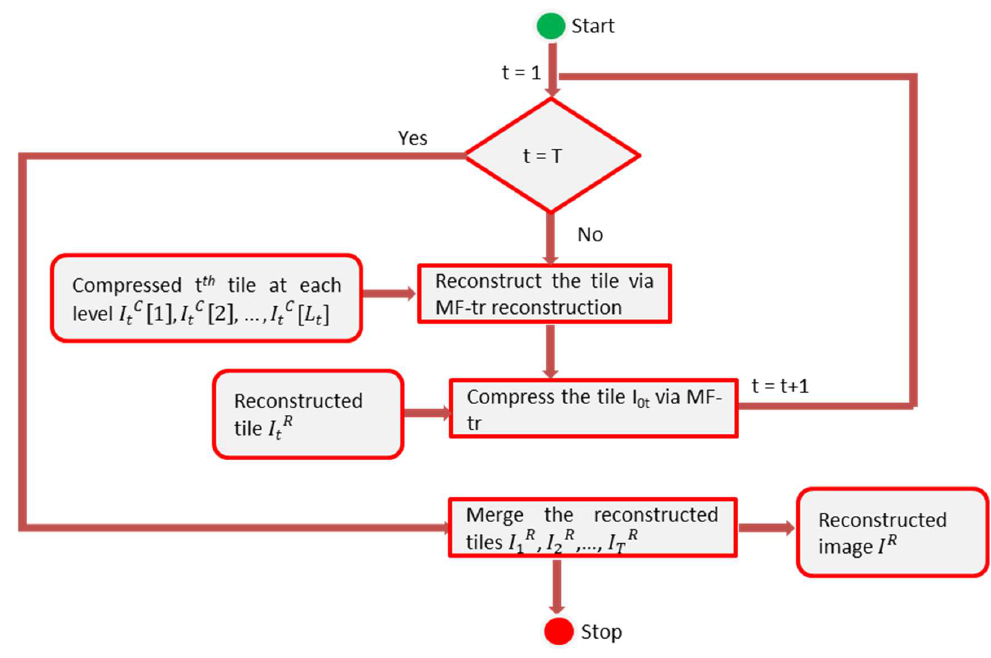
Figure 3. Flow diagram of the MIMF-tr image reconstruction algorithm.